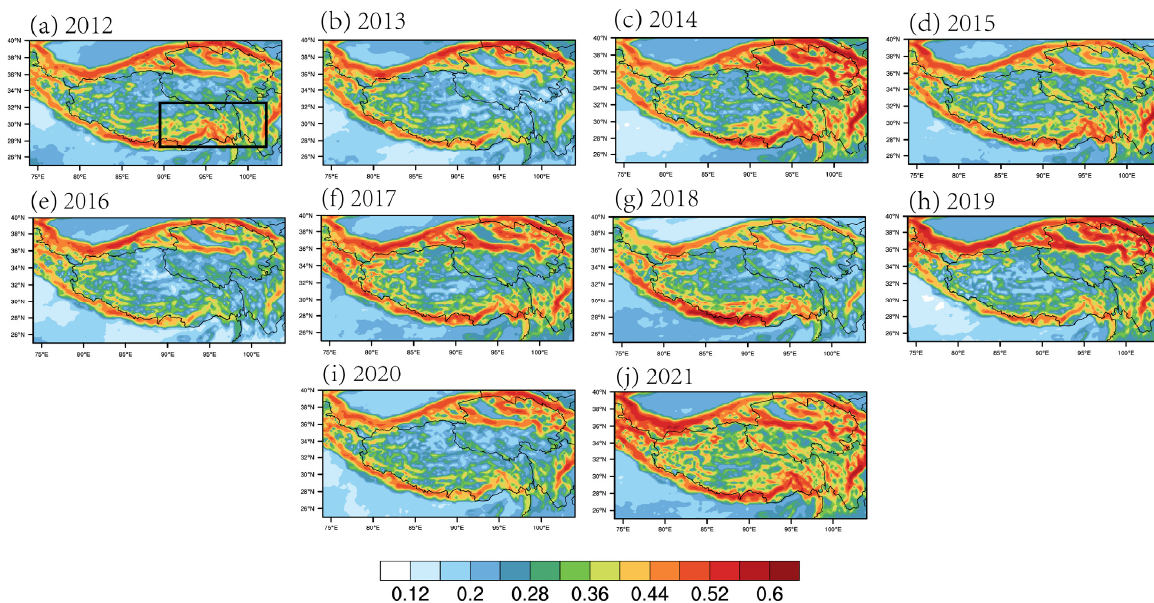
Figure 6. The average PI for LOG turbulence on 200 hPa in August from 2012–2021. The black square in Figure 6a represents the key area of interannual variation in